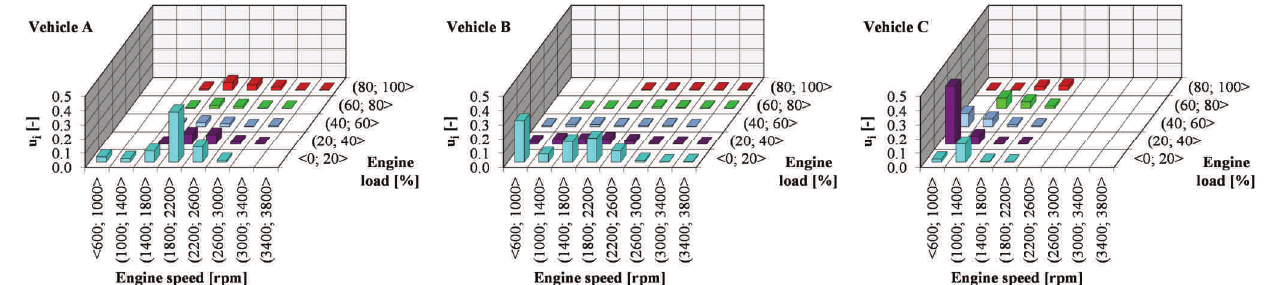
Fig. 5. Operating time shares of internal combustion engines in crankshaft speed and load ranges obtained in road tests